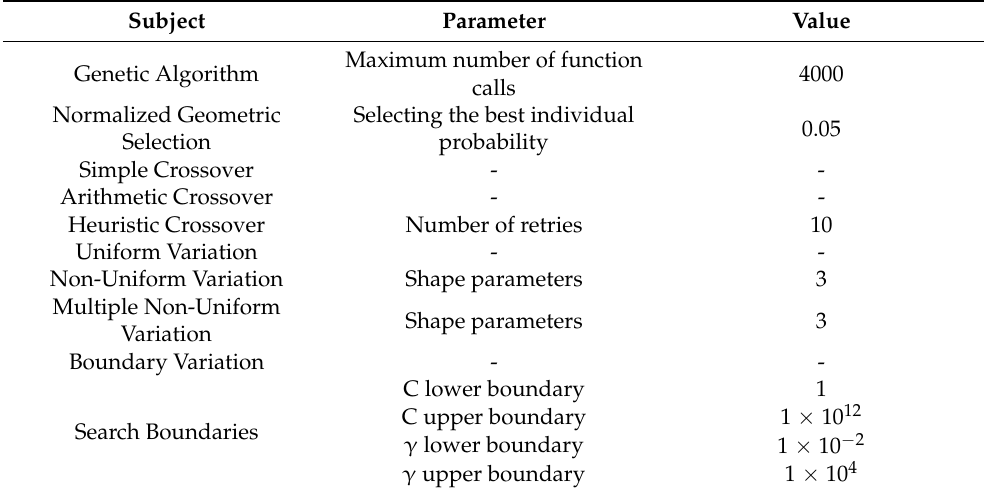
Table A2. Genetic algorithm parameter setting and search boundaries for the plant community classification model.